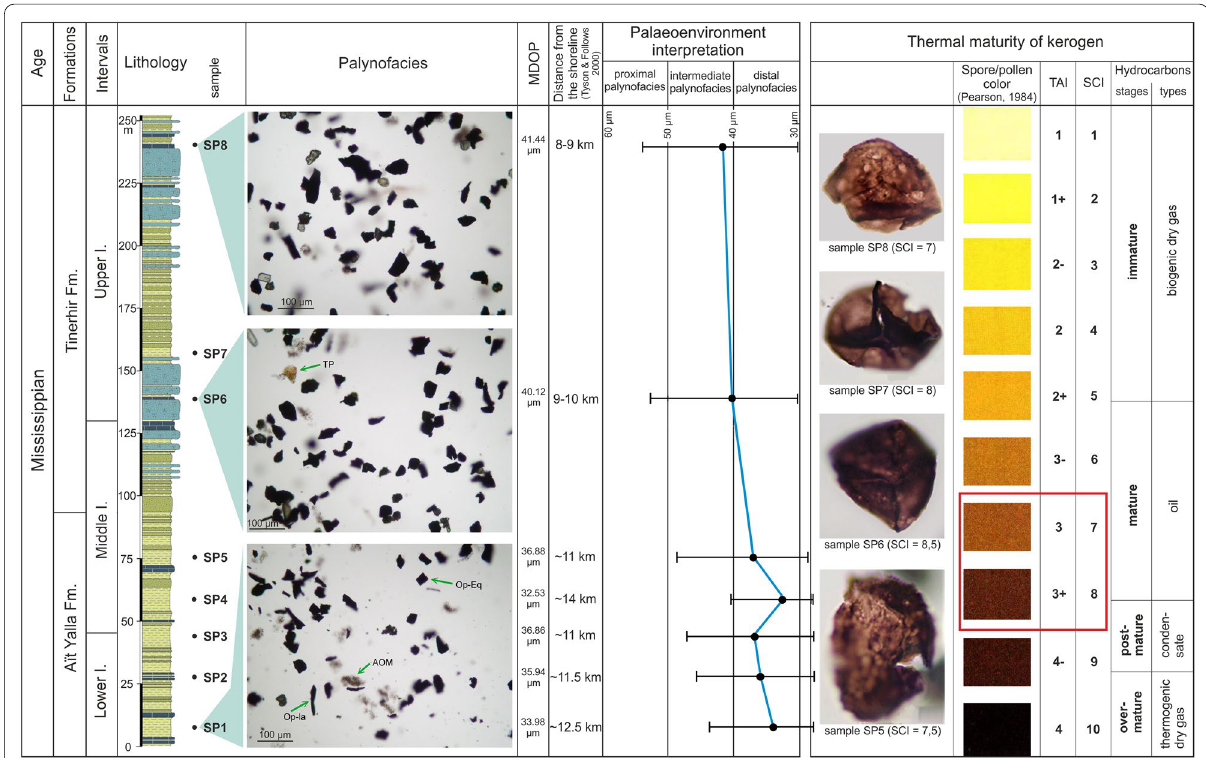
Fig. 6 Palynofacies composition, palaeoenvironment and thermal maturity interpretations inferred for the studied section. Thermal maturity estimation of organic matter is compiled after several authors (e.g., the spore/pollen color changes correlated with TAI values are adapted from Pearson, 1984; the correlation of TAI and SCI values with hydrocarbon stages —immature up to overmature— are adapted from Hartkopf-Fröder et al., 2015). The palaeoenvironment interpretation (proximal–distal palynofacies), according to Jurkowska & Barski (2017). AOM: amorphous organic matter; Op-Eq: equidimensional opaque phytoclast; Op-la: lath-shaped opaque phytoclasts; TP: translucent phytoclast; MDOP: mean diameter of opaque phytoclasts. The mean diameters of the phytoclasts (in µm) were obtained by counting at least one hundred of phytoclasts from each